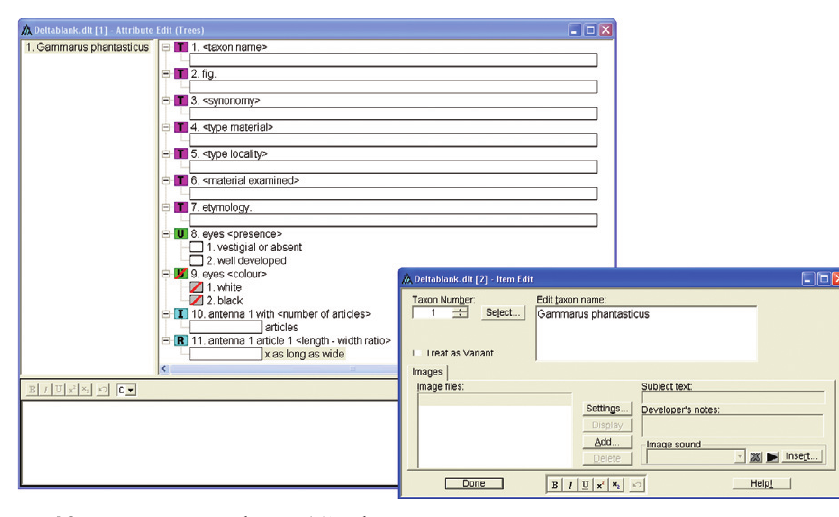
Figure 10. Inserting taxa in the DELTA Editor.